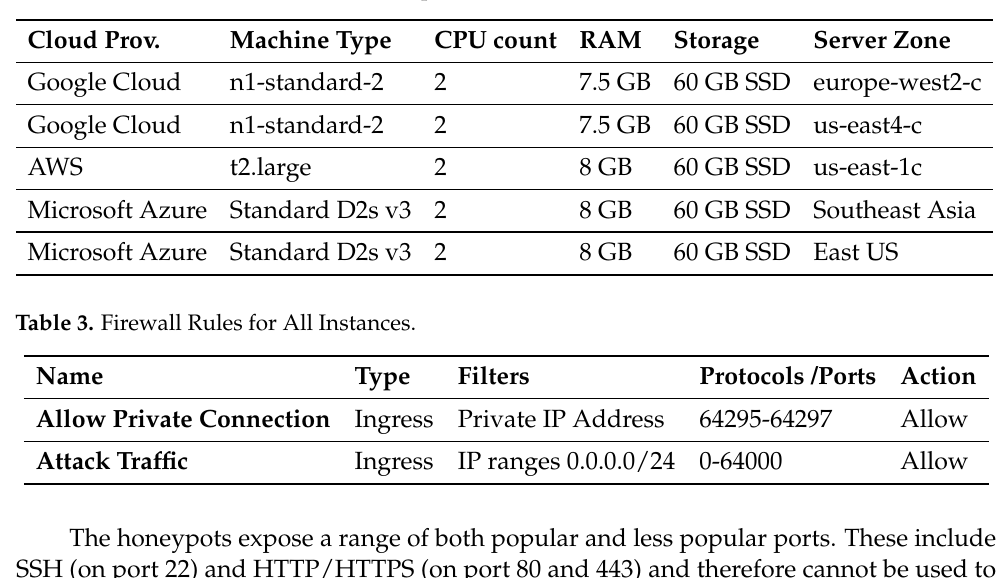
Table 2. GCP, AWS and Azure Instance Specifications.